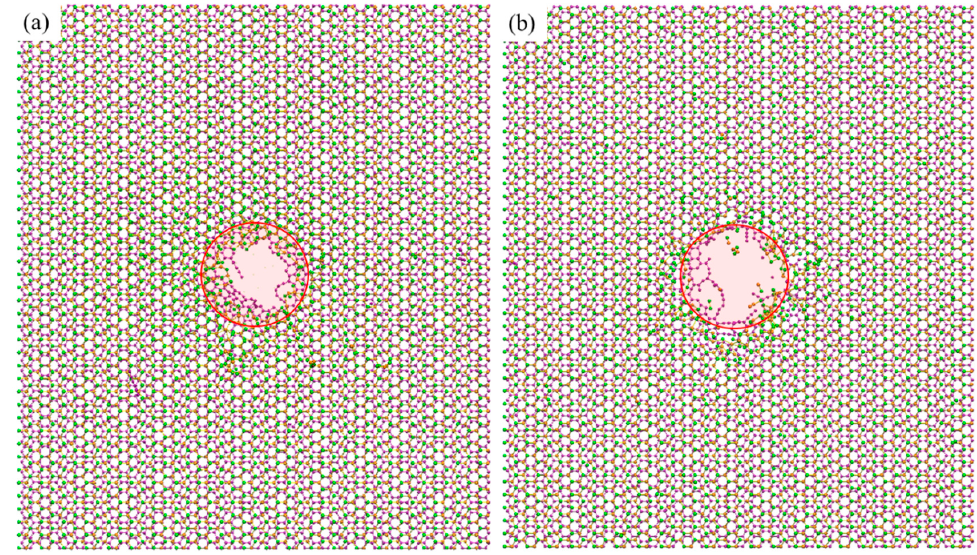
Figure 3. Morphologies of the G/M heterostructure under ion irradiation with a parameter pair of ( a ) 80 eV, and 2.54 × 10 16 /cm 2 . ( b ) 5000 eV, 3.18 × 10 15 /cm 2 . The red colored circle is used to indicate the irradiation area.